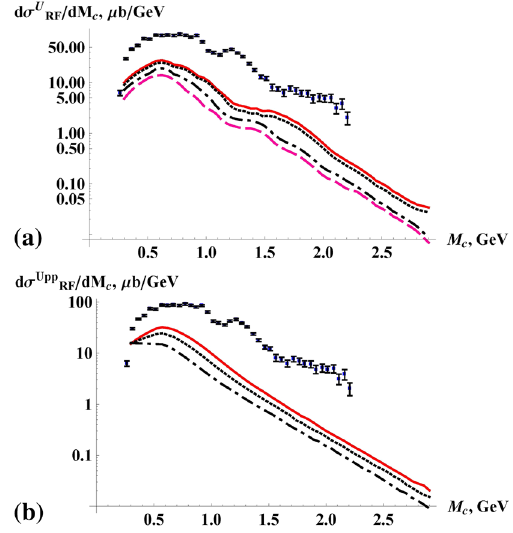
Fig. 12 RF case of the model (see Fig. 3) with all rescattering cor- Fig. 10 RF case of the model (see Fig. 3) with all rescattering cor- rections ( a ) and also when we try to fit the data by formulas without rections ( a ) and also when we try to fit the data by formulae without final pion–proton rescattering ( b ). The data on the process p + ¯ p → √ final pion–proton rescattering ( b ). The data on the process p + p → √ s = 1 . 96 TeV, | η π | < 1 . 3, | y ππ | < 1, p + π + + π − + ¯ p at p + π + + π − + p at s = 62 GeV, | y π | < 1 . 5, ξ p > 0 . 9, (ISR p T ,π > 0 . 4 GeV, p T ,ππ > 1 GeV, (CDF collaboration [19,20]). and ABCDHW collaborations [15,16]). Curves from up to down corre- Curves from up to down correspond to different values of the parameter spond to different values of the parameter Λ π in the off-shell pion form Λ π in the off-shell pion form factor (11): a Λ π = 4 , 3 , 1 . 6 , 1 . 2 GeV, factor (11): a Λ π = 4 , 3 , 1 . 6 , 1 . 2 GeV, b Λ π = 1 . 2 , 1 , 0 . 8 GeV b Λ π = 1 . 2 , 1 , 0 . 8 GeV